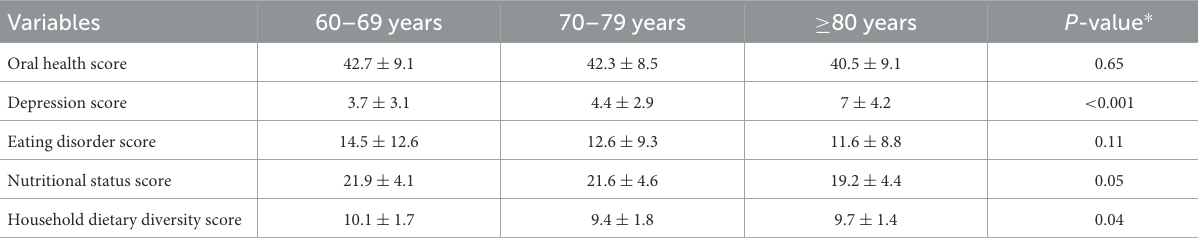
TABLE 2 Association of age with nutritional status and other health conditions.